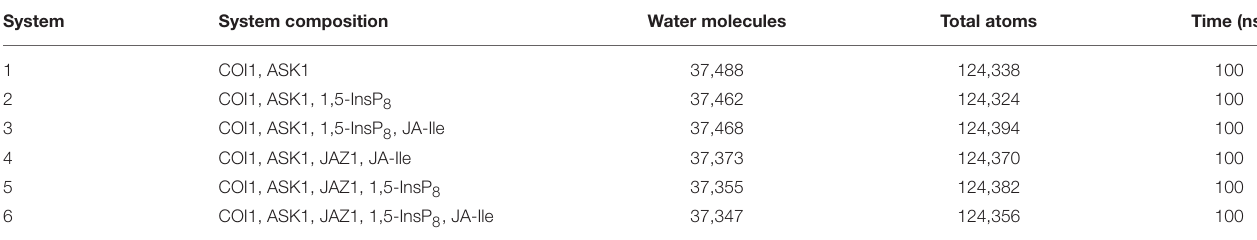
TABLE 1 | Summary of the six simulation systems.